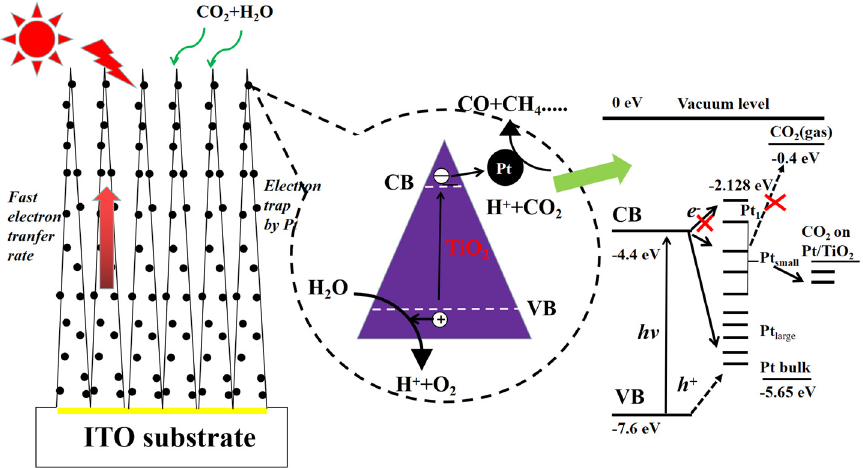
Figure 3. Mechanism diagram of CO 2 reduction by Pt-TiO 2 photocatalyst [74]. Yuan et al. [75] loaded 0.5% Pt by mass fraction onto P/g-C 3 N 4 composites